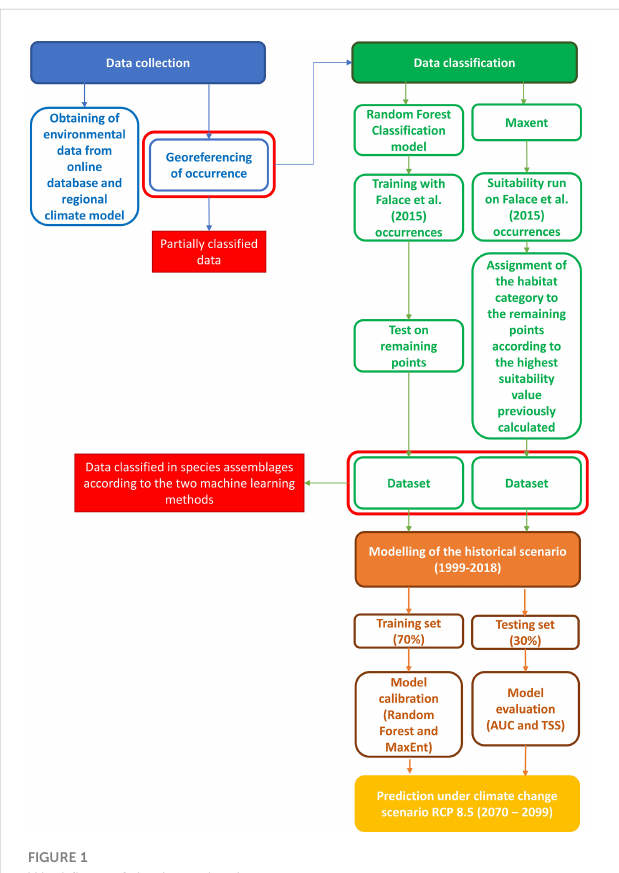
FIGURE 1 Work fl ow of the investigation